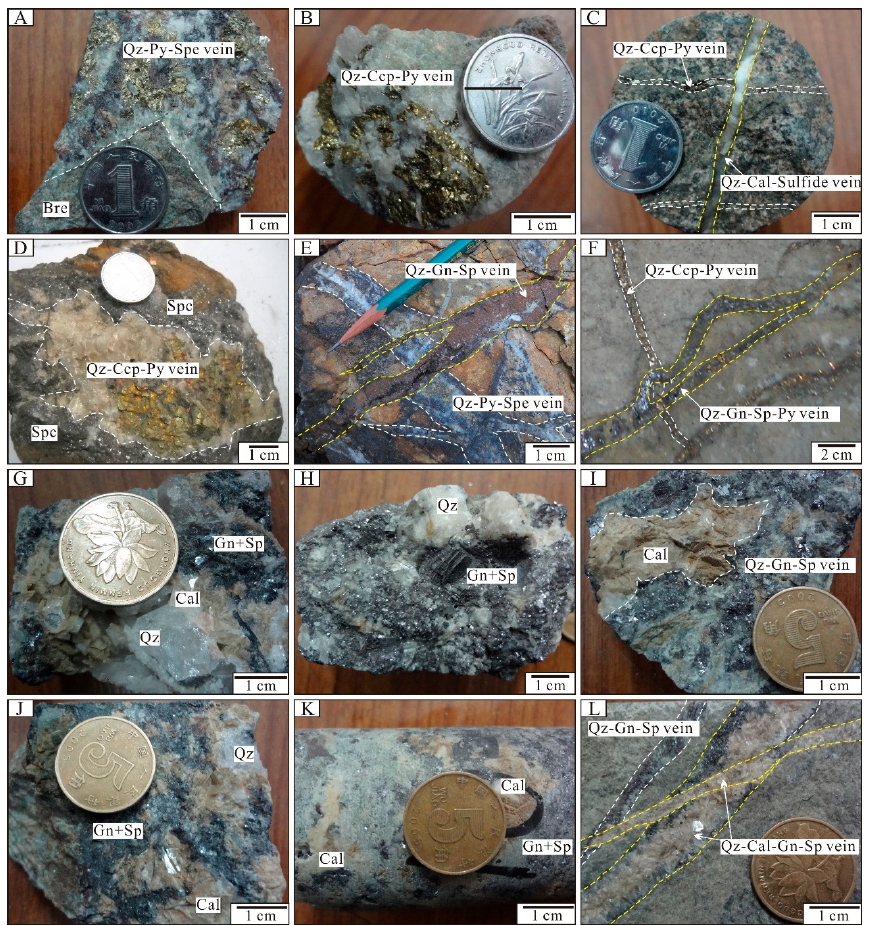
Figure 5. Photographs of ore from the Qibaoshan polymetallic ore field. ( A ) Quartz–pyrite–specularite vein from breccia-hosted ore in the Jinxiantou deposit; ( B ) Quartz–chalcopyrite–pyrite vein in the Jinxiantou deposit; ( C ) Quartz–chalcopyrite–pyrite vein cut by a later quartz–calcite–sulfide vein in the Jinxiantou deposit; ( D ) Quartz–pyrite–specularite vein cut by a later quartz–chalcopyrite–pyrite vein in the Changgou deposit; ( E ) Quartz–pyrite–specularite vein cut by a later quartz–sphalerite–galena vein in the Changgou deposit; ( F ) Quartz–chalcopyrite–pyrite vein cut by a later quartz–sphalerite–galena vein in the Changgou deposit; ( G ) Sphalerite–galena aggregate replaced by a later sulfide–poor–calcite aggregate in the Xingshanyu deposit; ( H ) Sphalerite–galena vein in the Xingshanyu deposit; ( I ) Sphalerite–galena vein cut by a later sulfide–poor–calcite vein in the Xingshanyu deposit; ( J ) Sphalerite–galena aggregate replaced by a later sulfide–poor–calcite aggregate in the Hongshigang deposit; ( K ) Sphalerite–galena vein cut by a later sulfide–poor–calcite vein in the Hongshigang deposit; and ( L ) Sphalerite–galena vein cut by a later sulfide–poor–calcite vein in the Hongshigang deposit. Abbreviations: Qz (quartz); Cal (calcite); Py (pyrite); Spe (specularite); Ccp (chalcopyrite); Sp (sphalerite); Gn (galena).